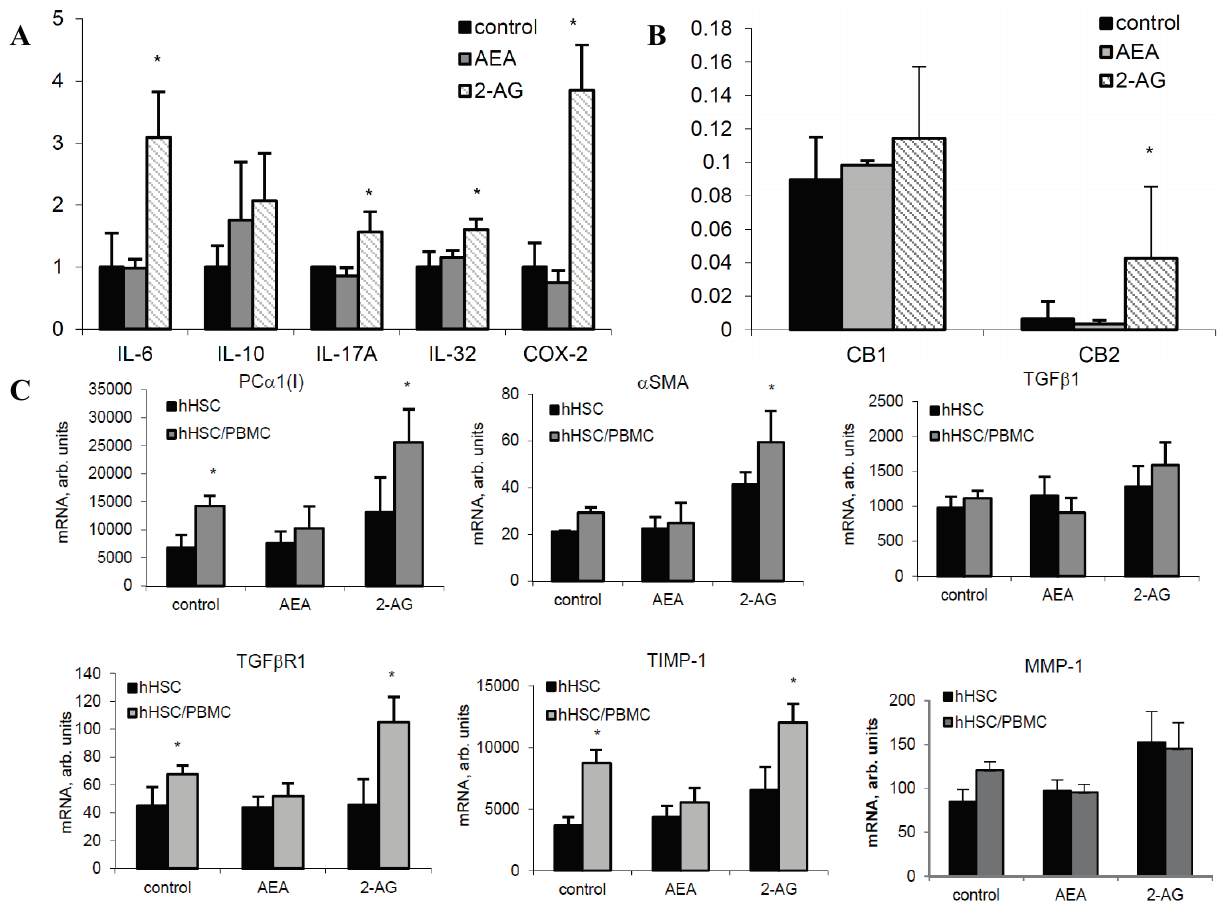
Figure 6. ECs affect inflammatory and fibrogenic hepatic cells activities. ( A ) Inflammatory cytokines mRNA and ( B ) CB1 and CB2 mRNA in human hepatocytes by 2.5 µM AEA and 20 µM 2-AG; ( C ) Fibrosis-related mRNA in hHSC and hHSC co-cultivated with PBMC from CHC patients by 2.5 µM AEA and 20 µM 2-AG. * p < 0.05 vs corresponding non-treated